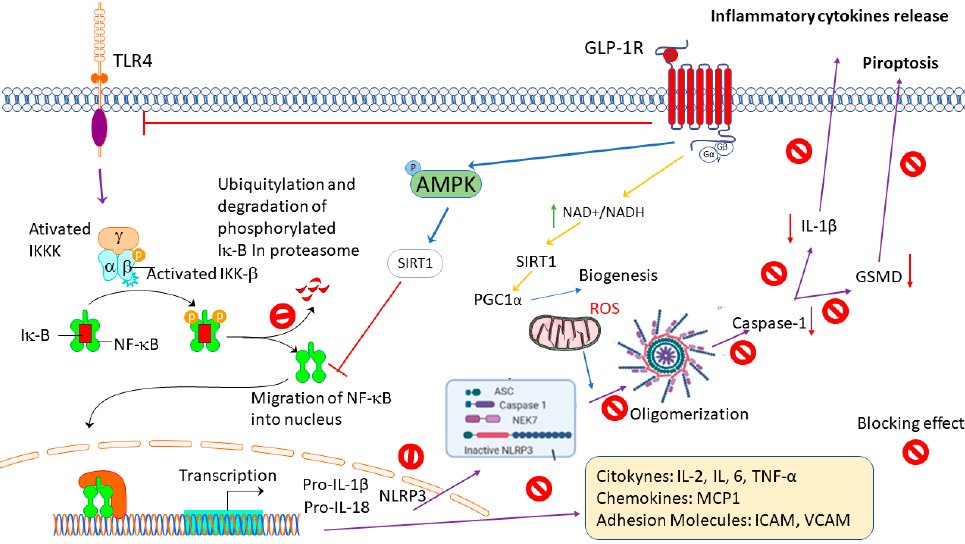
Figure 4. GLP-1 receptor activation induces an anti-inflammatory response. Abbreviatures: NF κ B: Nuclear Factor kappa B; IKKK: I κ B kinase kinase; IKK β : I κ B kinase β ; pro-IL-1 β : pro-interleukin-1 β ; pro-IL-18: pro-interleukin-18; ASC: Apoptosis-associated Speck-like protein containing a CARD; NEK7: NIMA Related Kinase 7; AMPK: adenosine monophosphate-activated protein kinase; SIRT1: Sirtuin 1; GSMD: Gasdermin D; IL-1 β : interleukin-1 β ; IL-2: interleukin-2; IL-6: interleukin-6; MCP1: Monocyte chemoattractant protein 1; ICAM: Intracellular adhesion molecule-1; VCAM: Vascular cell adhesion molecule-1; NAD/NADH: Nicotinamide adenine dinucleotide. Partially Biorender. com used.